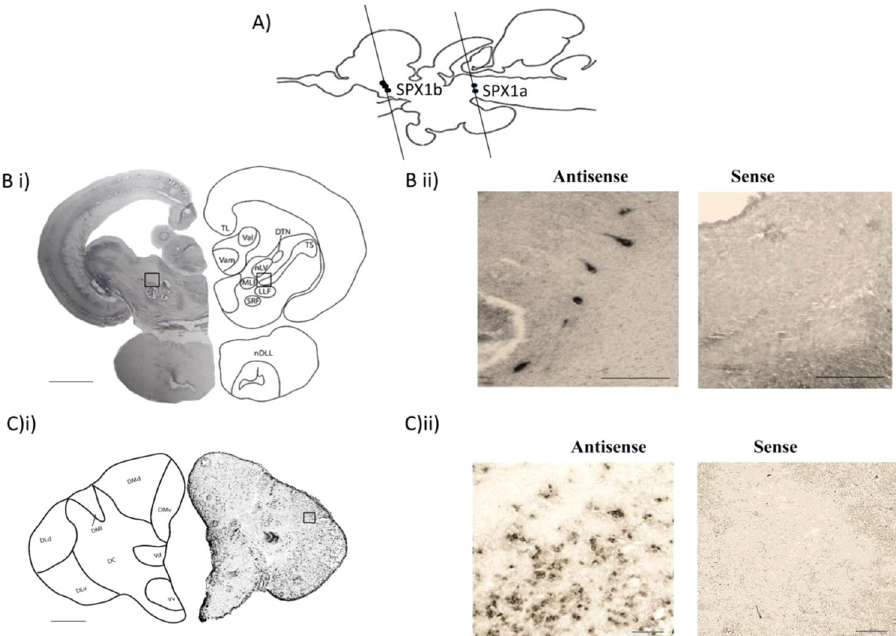
Figure 3. Localization of SPX1a and SPX1b expression in the Nile tilapia brain. ( A ) Sagittal section showing the signal of SPX1a and SPX1b with the relative position of the coronal section. ( B ) i) Coronal section showing the signal of SPX1a. SPX1a was localized in the ventromedial nucleus of semicircular torus (TS). (Scale bars = 500 μ m). ( B ) ii) Photomicrographs of the signal with 20x magnification. (Scale bars = 100 μ m) .( C ) i) Coronal section showing the signal of SPX1b. SPX1b was localized in the telencephalon, with heavy staining observed in the lateral part of the dorsal telencephalon. (Scale bars = 500 μ m). ( C ) ii) Photomicrographs of the signal with 40x magnification. (Scale bars = 50 μ m) TL, longitudinal torus, Val, Lateral valvula cerebelli, Vam, Medial valvula cerebelli, DTN, Dorsal tegmental nucleus, nLV, Lateral valvular nucleus, mLF, medial longitudinal fascicle, SRF, superior reticular formation, LLF Lateral longitudinal fascicle, TS, semicircular torus, nDLL, diffuse nucleus of the lateral lobe. Dmd, medio-dorsal area of dorsal telencephalon; Dmv, medio-ventral area of dorsal telencephalon; DM1, Subdivision 1 of the medial zone of the dorsal telencephalon; DC, central zone; DLd, dorsal subdivision of lateral part of dorsal telencephalon; DLV, ventral subdivision of lateral part of dorsal telencephalon; Vd, dorsal part of the ventral telencephalon; Vv, ventral nucleus of the ventral